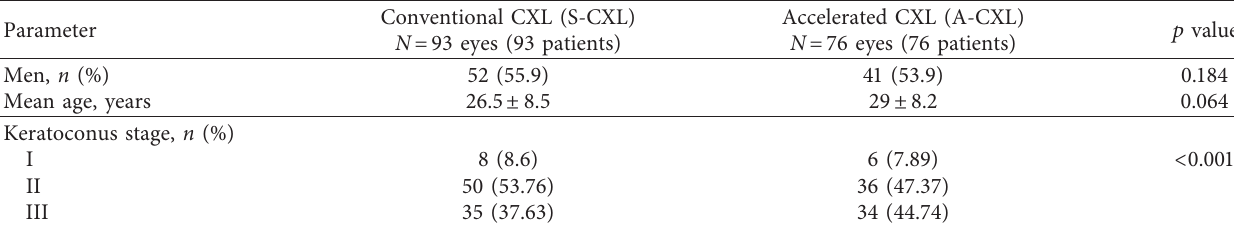
Table 1: Gender, age, and keratoconus stage in both